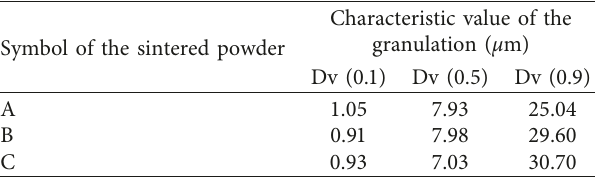
Table 3: Values characteristic for the granular composition of sintered powders A, B, and